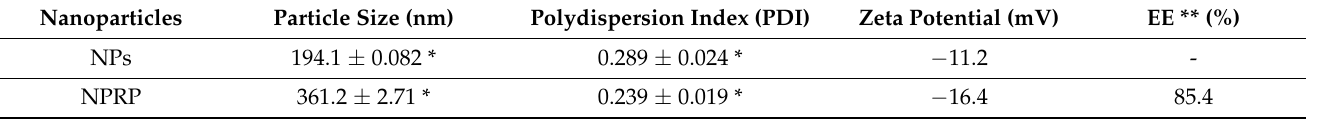
Table 4. Particle size, polydispersion index, zeta potential, and encapsulation efficiency of NPs and NPRP.